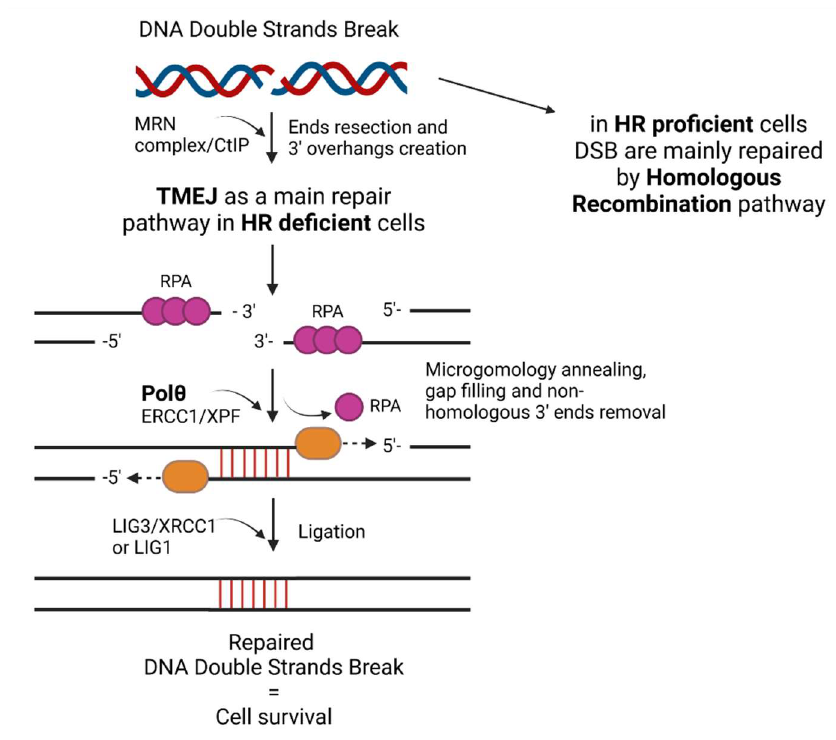
Figure 1. The mechanism of DNA double strand break repair by TMEJ in HR-deficient cells.